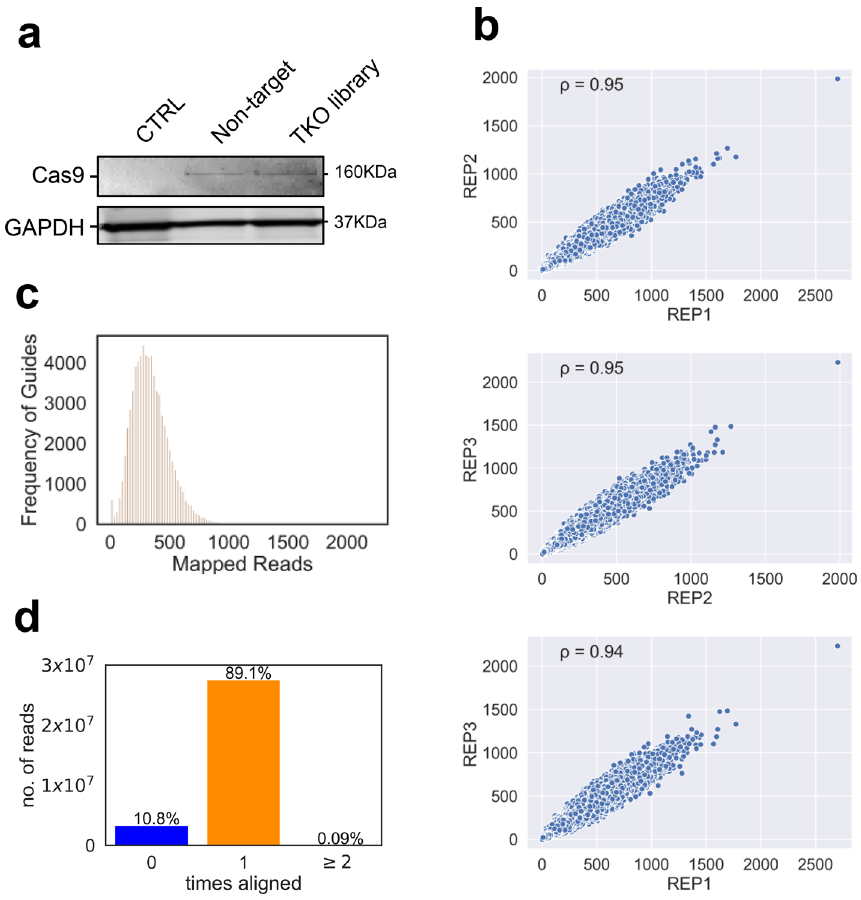
Figure 2. Delivery of genome-wide knockout library to iPSC-derived macrophages. ( a ) Western blot analysis of Cas9 expression in TKOv3-transduced cells using anti-Cas9 antibody detected an ~ 160 kDa band. GAPDH loading control. ( b ) Scatter plots comparing the abundance of each of the guides sequenced for each of the replicates. Pearson’s correlation coefficient is reported for each pairwise comparison, with the correlation coefficient > 0.9 for each comparison. ( c ) Histogram showing the distribution of reads for the guides, with a mean of 339 reads per guide and a maximum of 2233 reads per guide. ( d ) Graph showing mapped sequences of the gDNA to the TKOv3 library. We found 89.1% of the sequences mapped to one guide in the library, 10.8% of the sequences were mapped to nothing in the library and 0.09% of the guides mapped to two or more guides in the